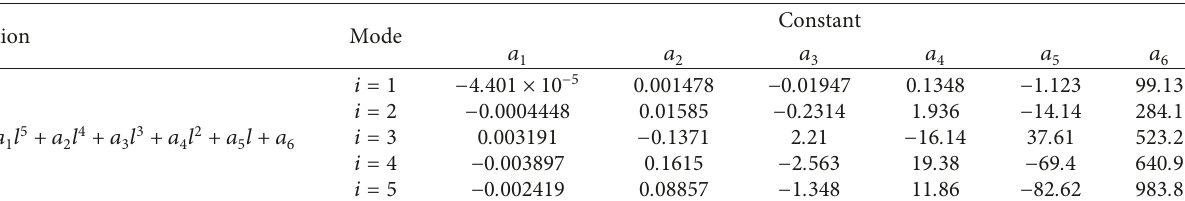
Figure 13: Relationship between frequency and cell size. Table 4: Function relationship.